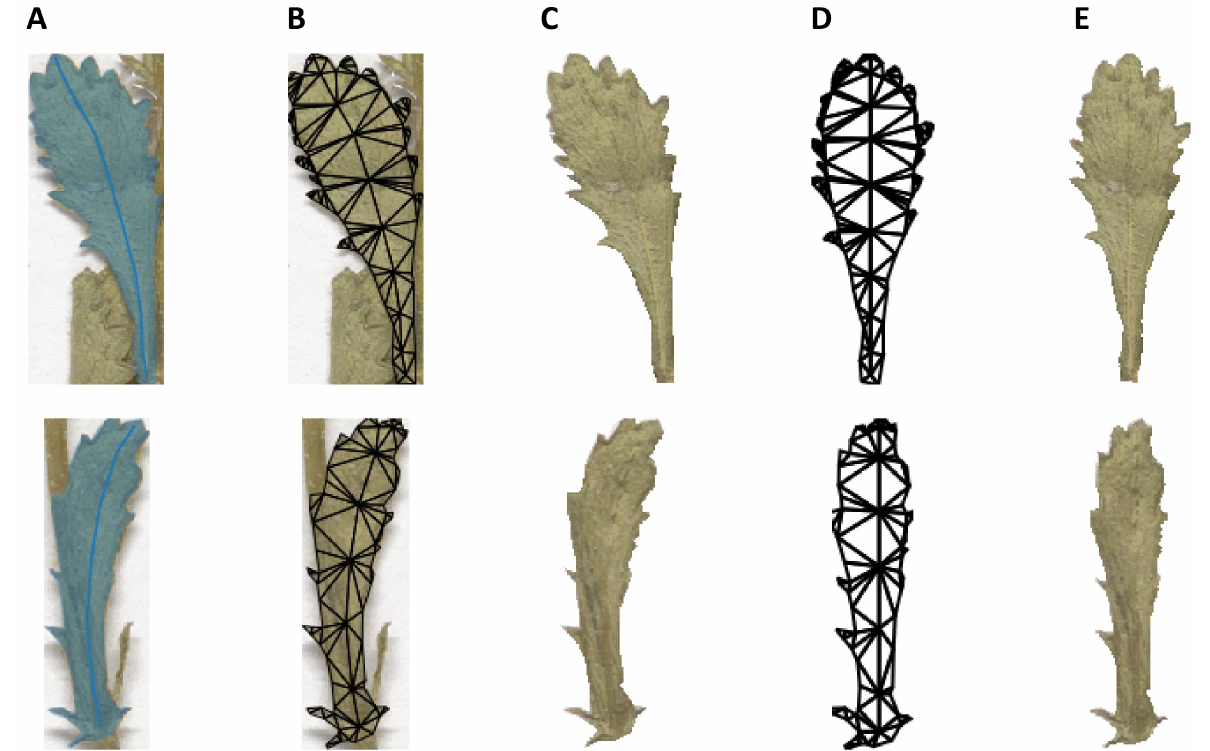
Figure 4. Leaf straightening process illustration. The leaf and midvein annotations ( A ) are used to construct a triangle mesh ( B ). Based on this mesh, the background is removed ( C ). The midvein points are arranged in a straight line, preserving distances between line vertices; the remaining vertices are updated according to the as-rigid-as-possible algorithm ( D ). Finally, the texture from the bent leaf mesh is mapped to the straightened leaf mesh ( E ).